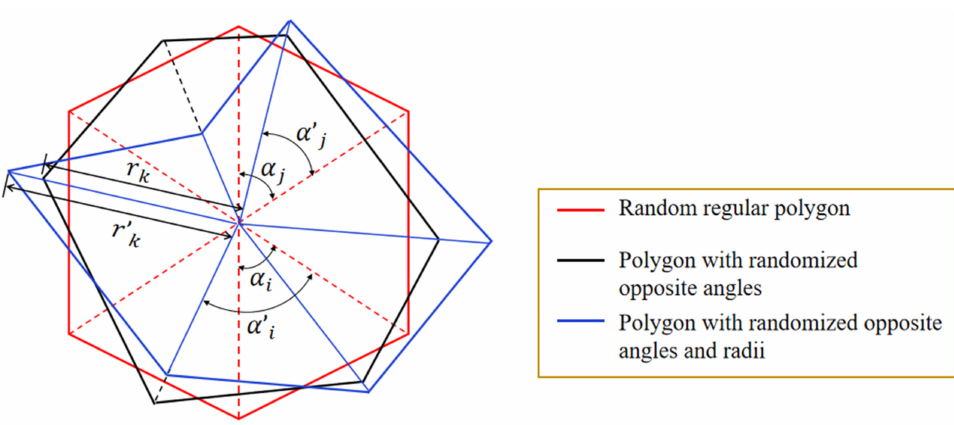
Figure 1. The generation process of random polygonal